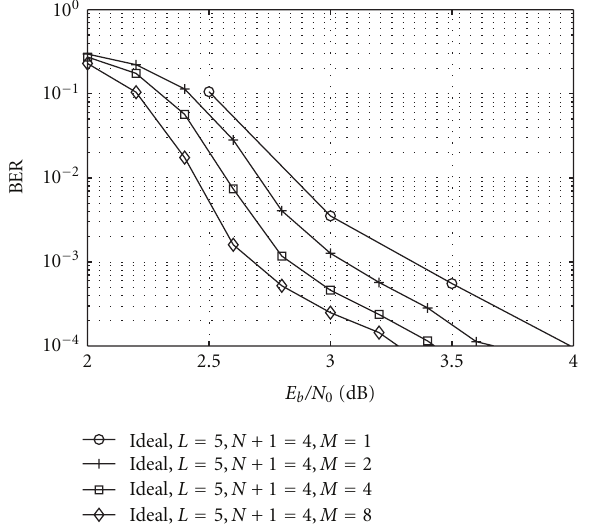
Figure 14: Bit error performance for the TU-6 COST-207 channel with the solid lines for f d T u = 0 . 01, the dashed lines for f d T u = 0 . 02, N + 1 = (4,18), M = (8,1), and L = 5